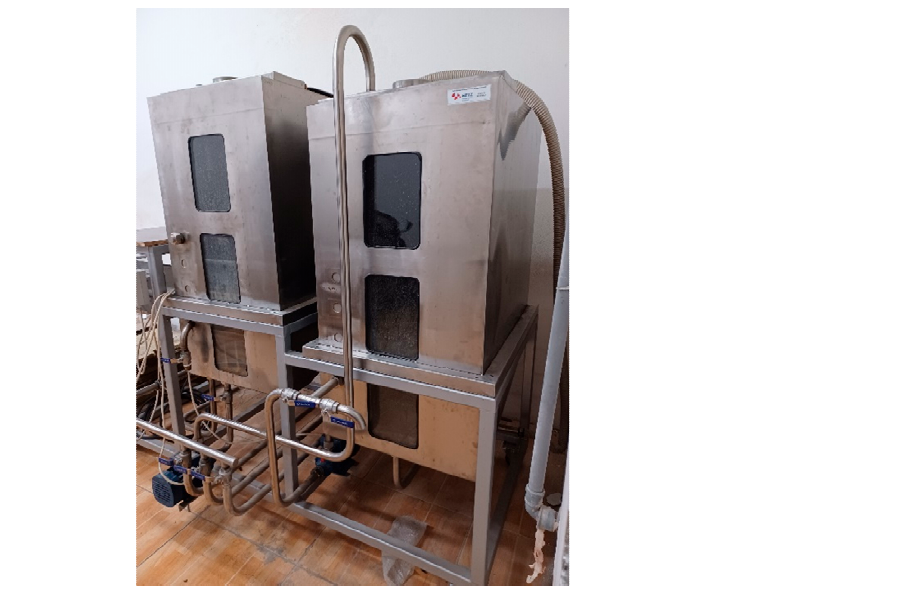
Figure 1 . Pilot plant for the treatment of oily wastewater using pretreatment and EF/EC processes